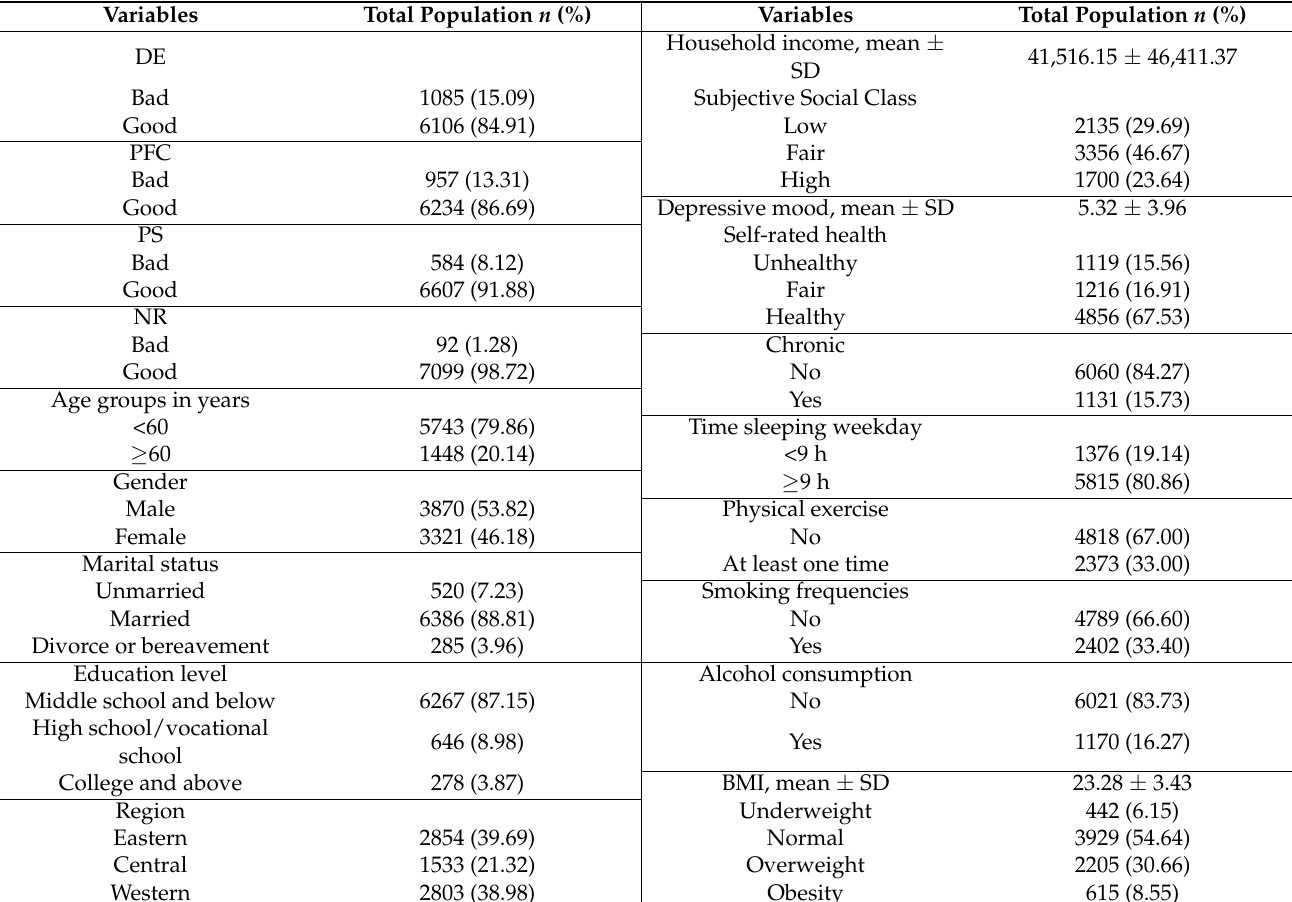
Table 1. Characteristics of the study